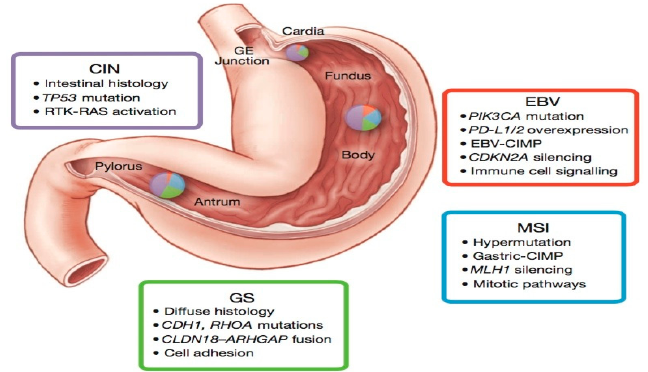
Figure 1. The four molecular subtypes described in the TCGA study, their mutational patterns, and location. CIN, chromosomal instability; EBV, Epstein–Barr virus; GE, gastroesophageal junction; GS, genomically stable; MSI, microsatellite instability. This figure is reproduced from reference [14] with permission from the Nature Publishing Group.